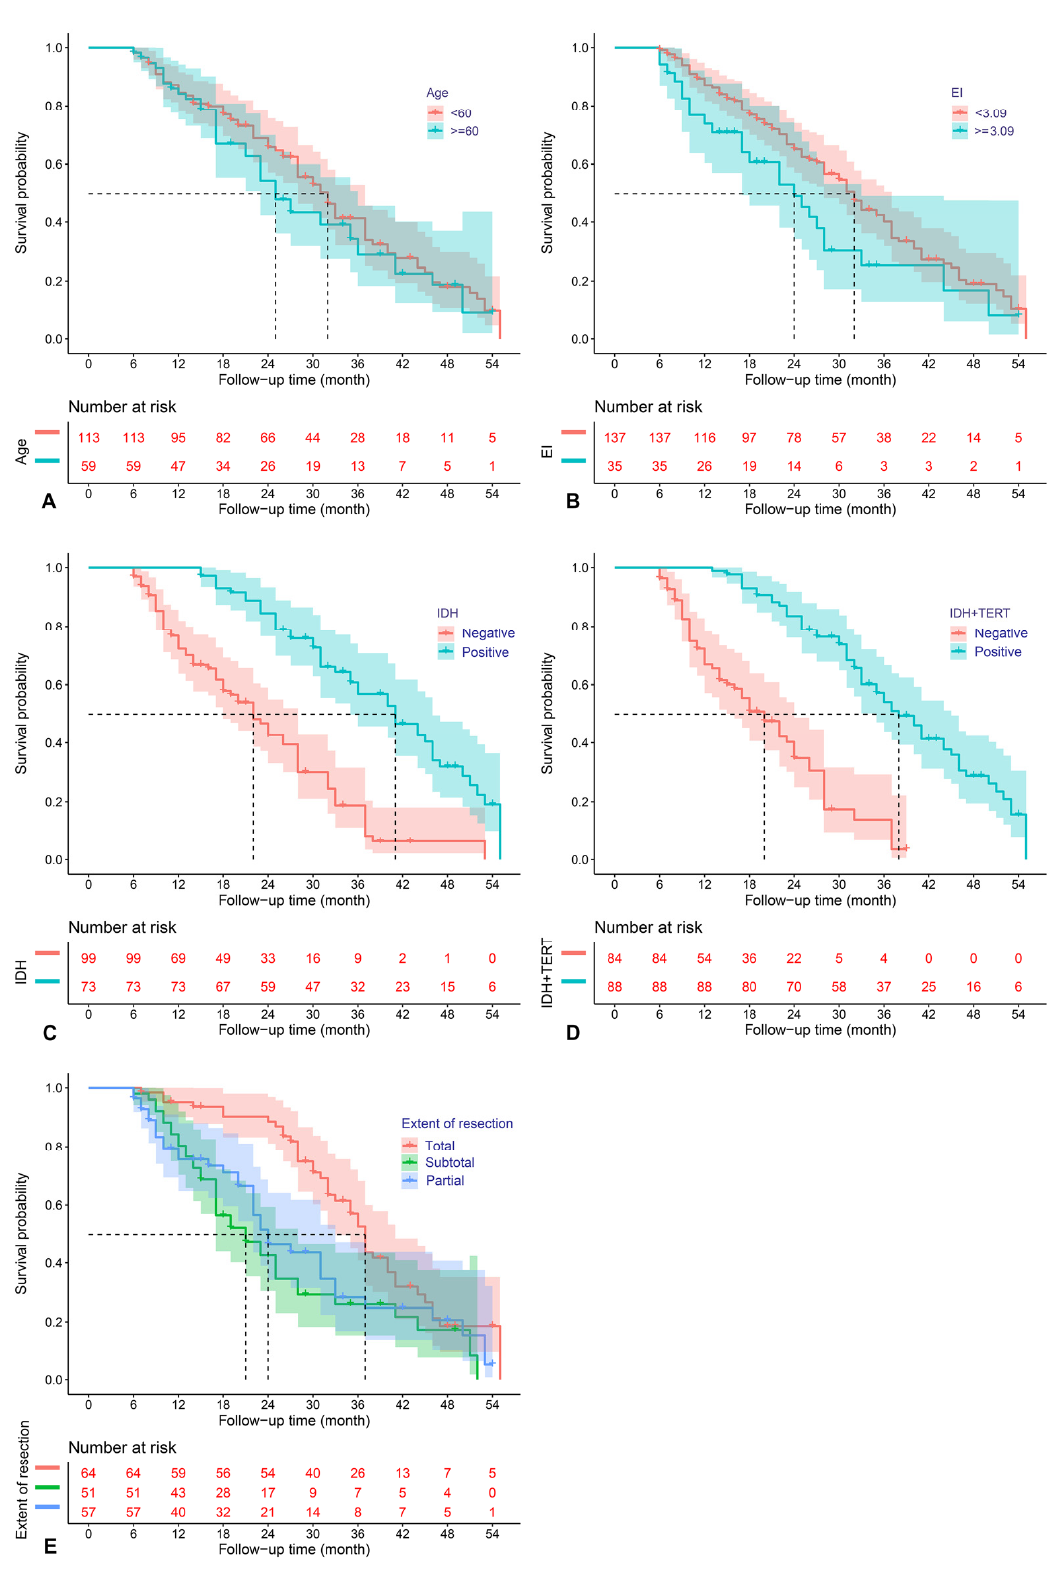
Figure 2. Kaplan–Meier survival curves for age ( A ), edema index ( B ), IDH mutation ( C ), IDH and TERT promoter co-mutation ( D ), and extent of resection ( E ), which were significantly associated with PFS in the multivariable analysis.